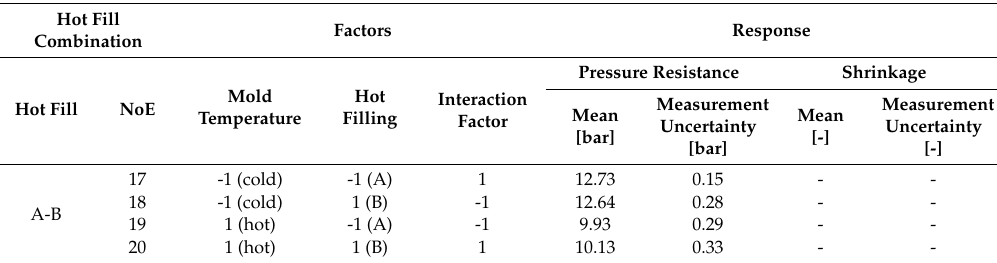
Table 8. Plans for three two-factor, bivalent experiments for testing pressure resistance and thermal stability (NoE—Number of